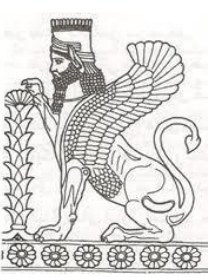
Figure 18. A motif of the sacred plant, Persepolis, wisgoon.com, 2005